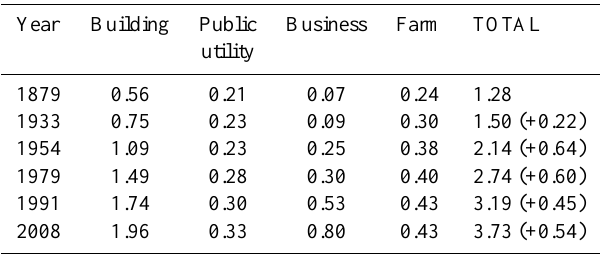
Table 4. Percent increase of the area occupied by the different cat- egories, comparison with the previous and the first year of analy- sis (in brackets). Measurements were done by GIS. The percent is calculated starting from value in Table 3, for example, considering buildings: (0.75–0.56)/0.56 ×